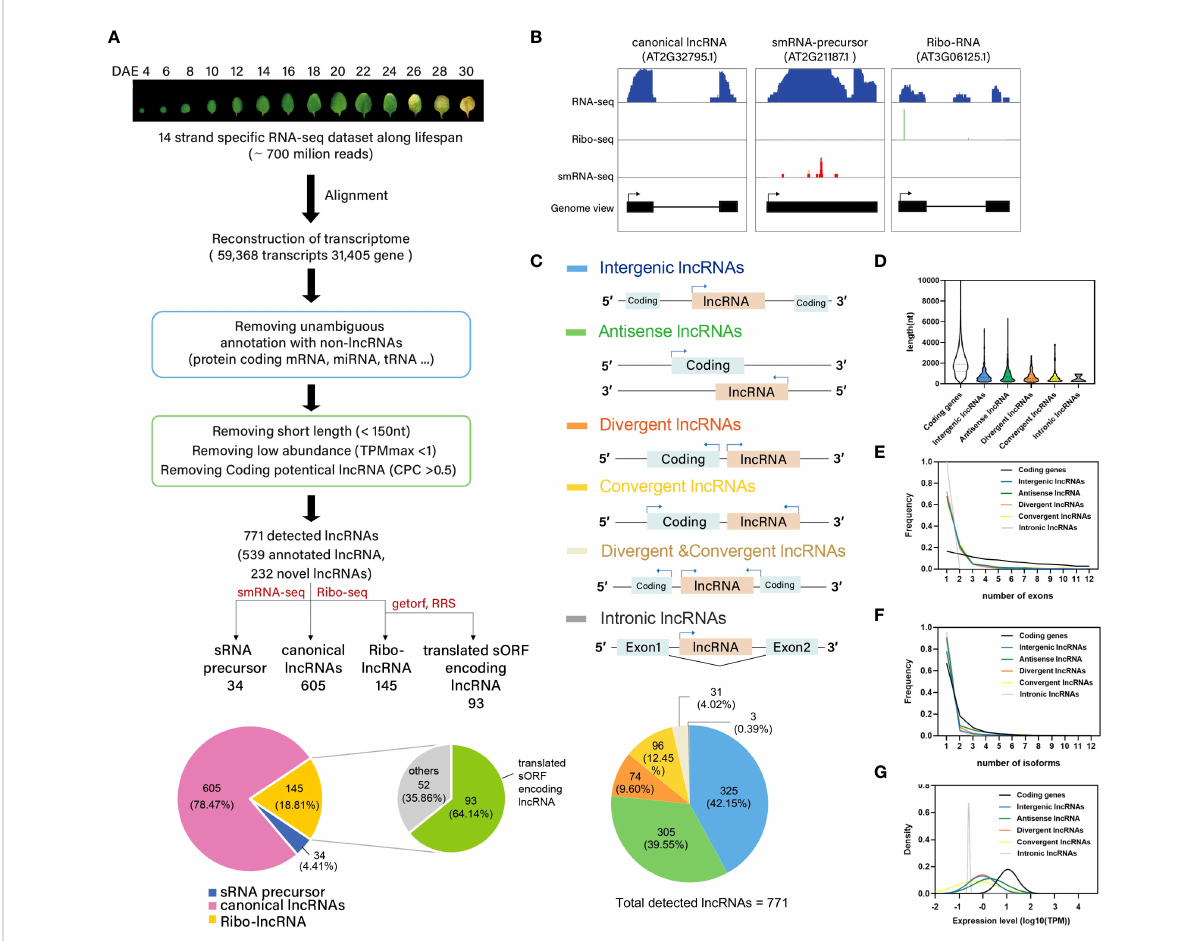
FIGURE 1 Genome-wide identi fi cation of lncRNA in Arabidopsis . (A) Pipeline for the systematic identi fi cation of lncRNAs in Arabidopsis . Note that there are 13 detected lncRNAs which were belonging to both sRNA precursor and Ribo-lncRNA. (B) Normalized read coverage of representative lncRNAs in each category, as measured by RNA-seq, sRNA-seq, and ribo-seq. (C) Classi fi cation of lncRNAs based on their genomic location. (D) Violin plot showing the length distribution of lncRNAs. (E) Frequency line plot showing the distribution of exon numbers in different lncRNAs. (F) Frequency line plot showing the distribution of isoform numbers of different lncRNAs. (G) Distribution curve of average expression levels of